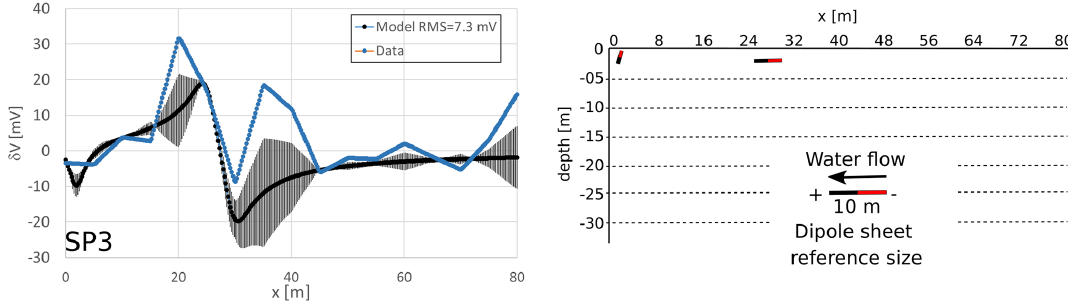
Figure A2. SP data and inversion results for profile